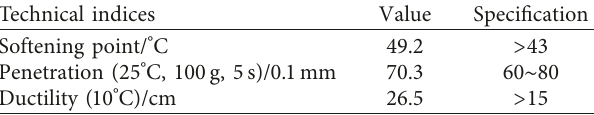
Table 1: Technical properties of 70# base